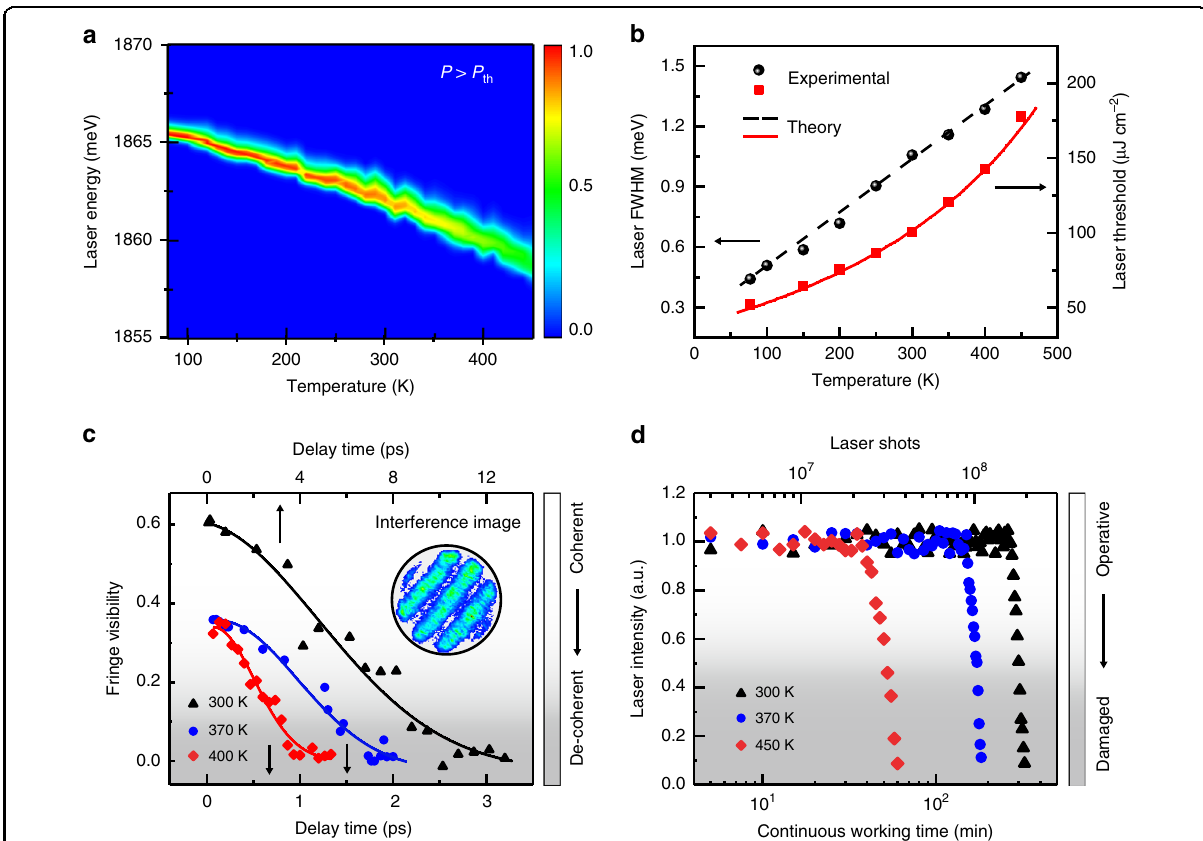
Fig. 3 Temperature-dependent laser characteristics of CQDAMs and thermal stability under continuous working conditions. a Normalized contour plots of the temperature-dependent lasing spectra from an individual CQDAM at excitation density above the threshold. b Temperature- dependent laser FWHM (black circle) and threshold (red square) in the range from 77 to 450 K. c The interference fringe visibility of the lasing output by using a Michelson interferometer. The coherent time is obtained by the time-dependent self-interference experiments. The dots are the experimental data, and the lines are the fi tting results. The corresponding coherence times at 300, 370, and 400 K are ~5.4, 0.85, and 0.44 ps, respectively. Inset: interference image. d Continuous working ability at different temperatures. The stable intense output from an individual CQDAM can be maintained for 40 min with 2.4 × 10 7 lasing pulses even at 450